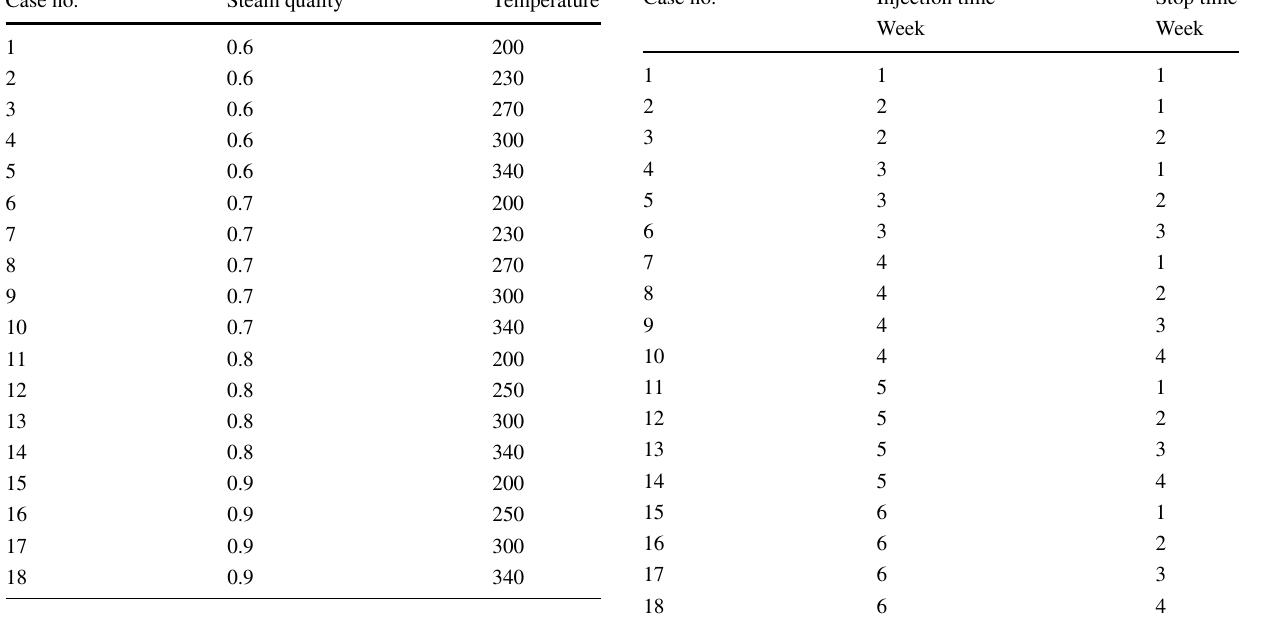
Table 10 Steam quality and seam temperature optimization cases Case no.